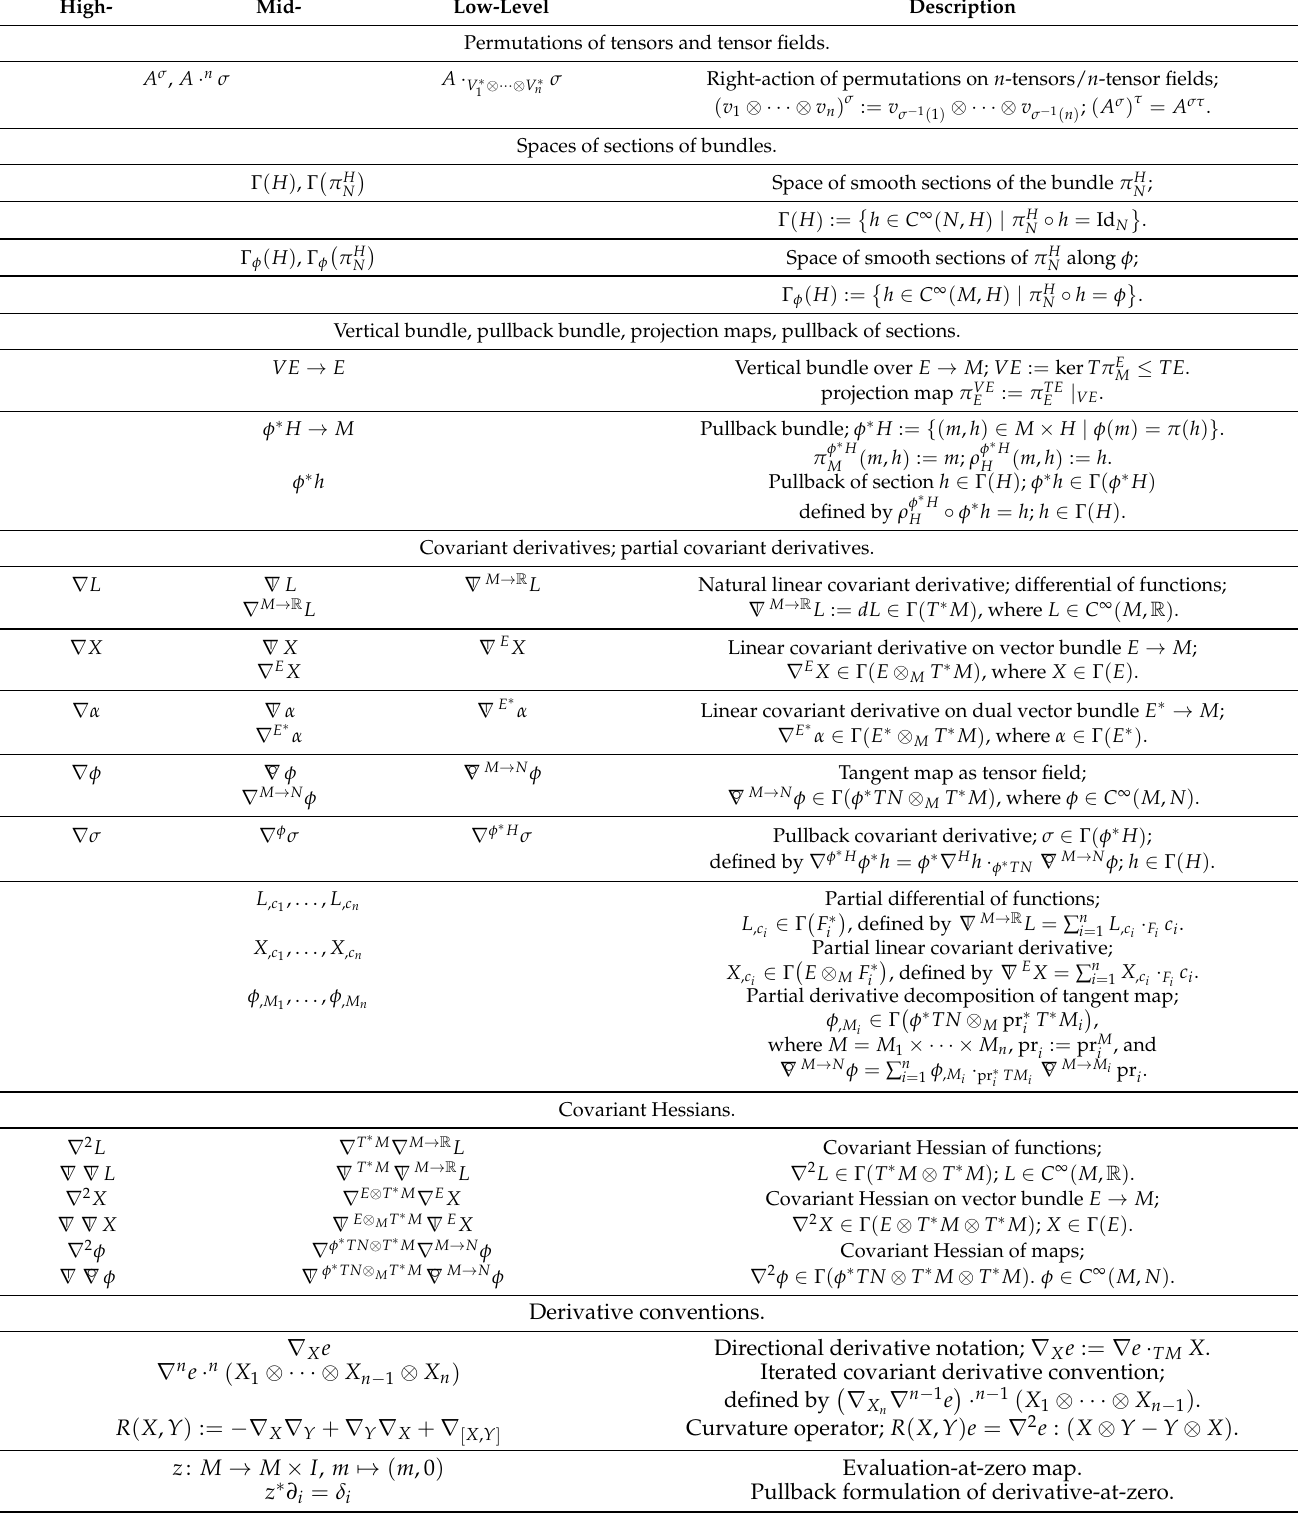
Table 2. Notational Reference Part